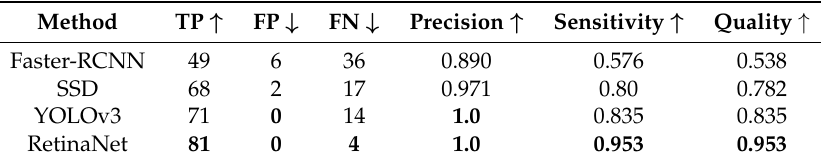
Table 1. Quantitative results of vehicle counting in 4K testing image. For each testing image, we show the TP, FP, FN, precision, sensitivity, and quality. The best values are highlighted by bold typefaces. The up arrow means that higher is better, and the down arrow means that lower is better. The best values are highlighted using a bold